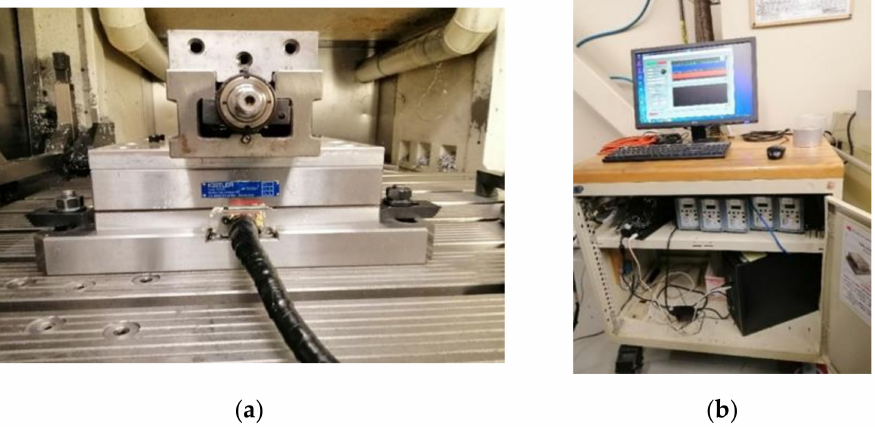
Figure 3. Cutting forces measurement system: ( a ) Kistler table, ( b ) Acquisition and analysis unit. The tools used were purchased from GranQuartz Canada Inc., Stanstead, QC, Canada. They consisted of six shaped tools with different grit sizes (Grits 45, 150, 300, 600, 1500, and 3000), which transformed the sharp edge of the granite sample (i.e., work part) into a rounded edge with 10 mm radius and gave a polished and shiny appearance to the part.